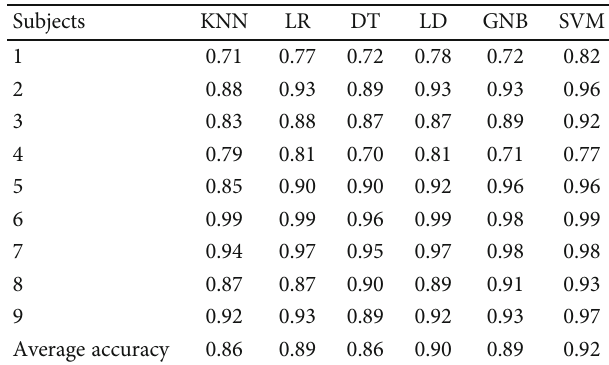
Table 3: Confusion matrix and parameter evaluation of classi fi ers applied to extracted features by FFT.